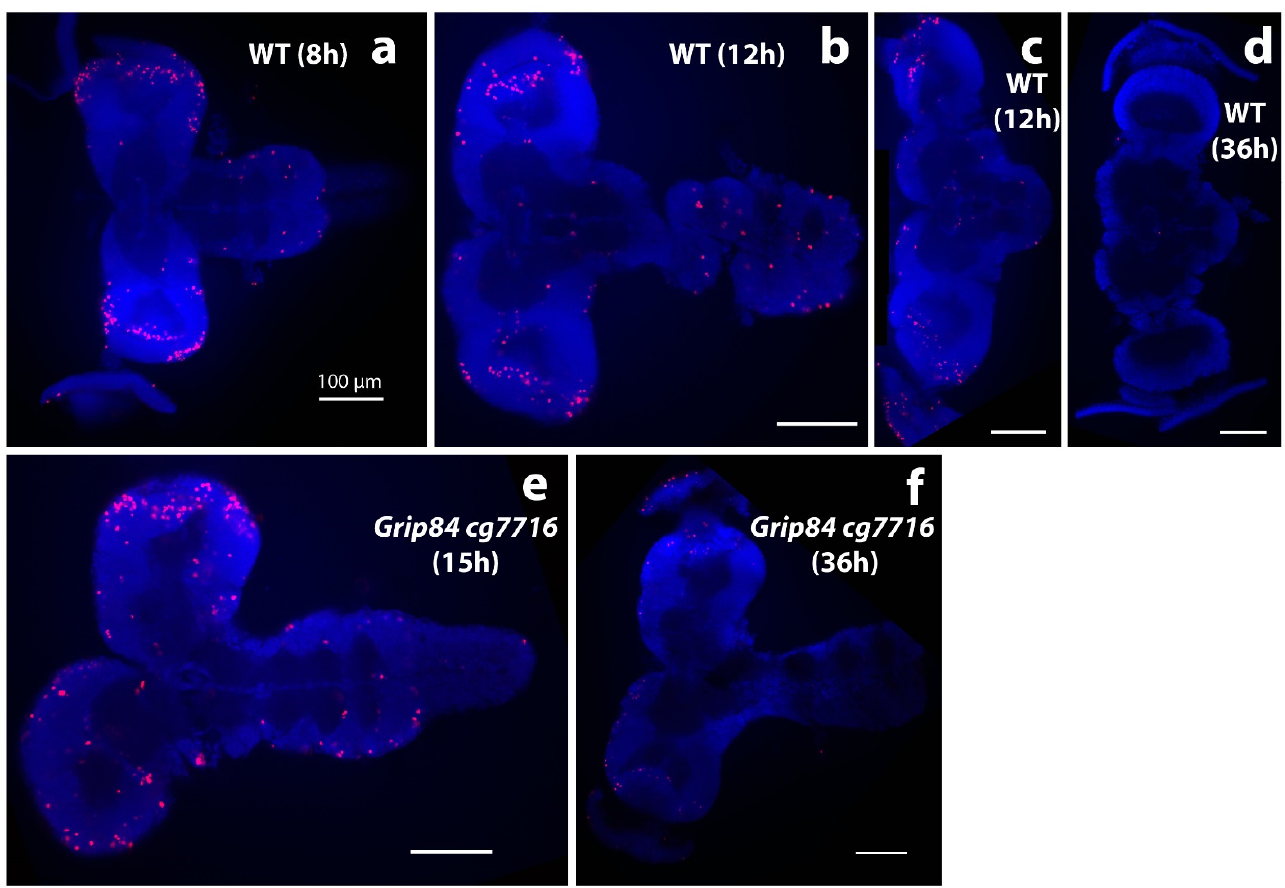
Figure 6. Brain morphology during pupation stained with DAPI stain (blue); anti-phospho-histone H3 (anti-pH3, red). ( a – d ) Brains from wild type siblings’ pupae; ( e,f ) Df(1)14.4; Mi{ET1}CG7716 MB07394 Dp(1;3)DC364 PBac{y + w + } mutants. ( a ) Normal pupal brains 8 h after pupal case formation resemble larval brains, although the hemispheres elongate distally and show clear mitotic zones at the tips, marked by anti-pH3. ( b ) Further elongation is seen at 12 h, when normal brain and ventral nerve cord lose tight connection. ( c ) The majority of normal brains are dissected separately at this time point. ( d ) WT brains one day later at 36 h look different; the connection to eyes becomes visible; mitoses are not seen. Early stage mutant brains resemble wild type. ( e ) Mutant brains at 15 h (after early adult body parts are formed in normal pupae) and ( f ) at 36 h resemble “early 12 h wild type”. At 36 h, brain mitoses are barely detected. White bar = 100 μ m.